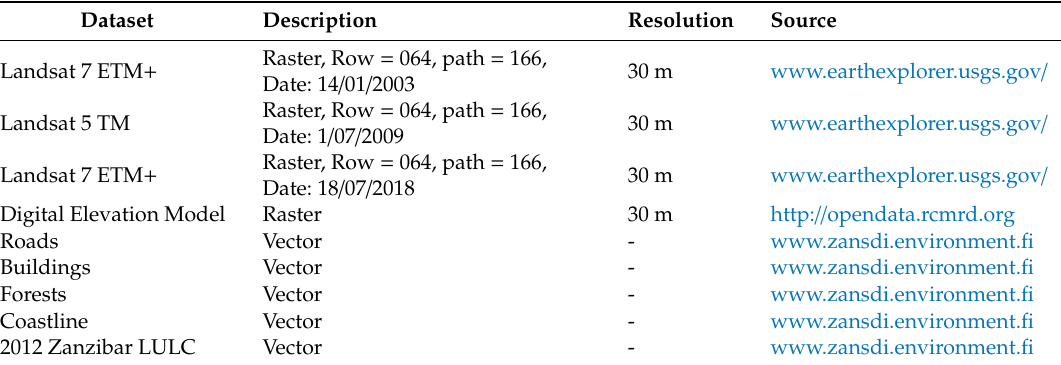
Table 1. Base data used in the